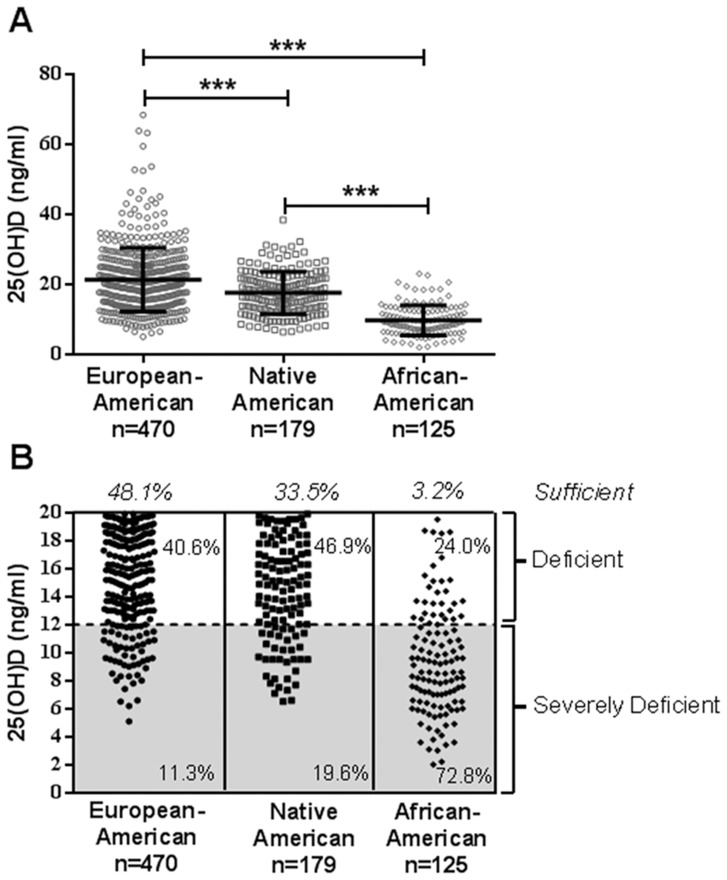
African-Americans and Native Americans have decreased 25(OH)D levels.(A) Median 25(OH)D levels for African-Americans (n = 125), Native Americans (n = 179), and European-Americans (n = 470). Error bars represent interquartile range. ***p<0.001, Kruskal-Wallis test with Dunn's multiple comparison; p<0.05, Shapiro-Wilk and D'Agostino normality test. (B) Frequency of vitamin D severe deficiency (<12 ng/mL) and vitamin D deficiency (12–20 ng/mL) in African-Americans, Native Americans, and European Americans. Each symbol represents one individual.